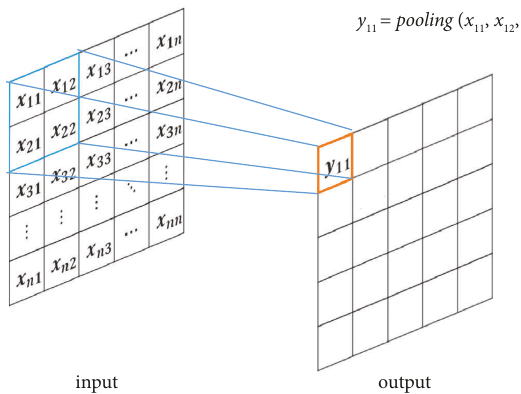
Figure 3: Schematic diagram of pooling